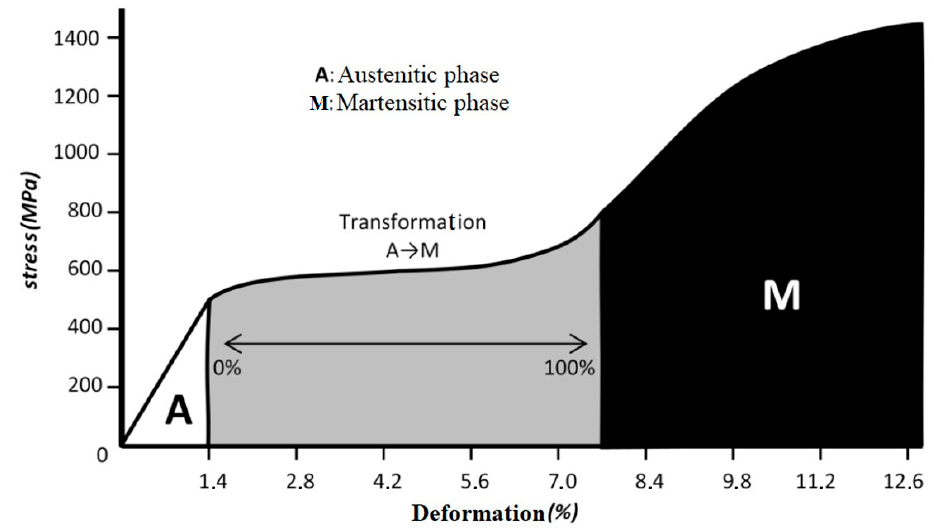
Figure 4. NiTi stress–strain graph. A: deformation of the austenitic phase (proportional elastic deformation). A-M: transition zone from austenitic (A) to martensitic (M), a large amount of deformation occurs without a large increase in stress. M: follows the typical behaviour of a stress–strain graph: linear elasticity, yield point and fracture point.